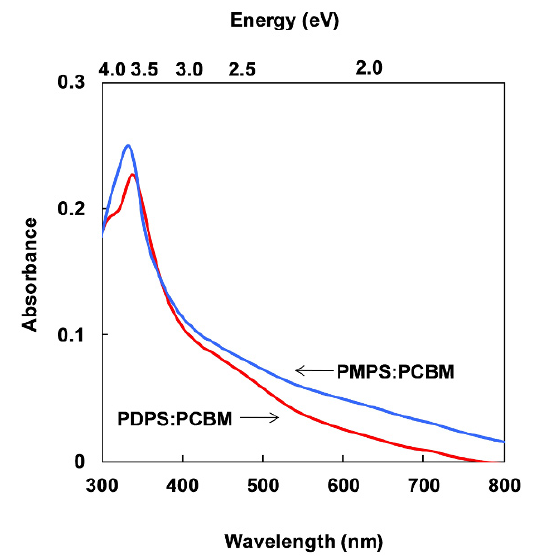
Figure 3. Photo absorption spectra of PMPS:PCBM and PDPS:PCBM thin films